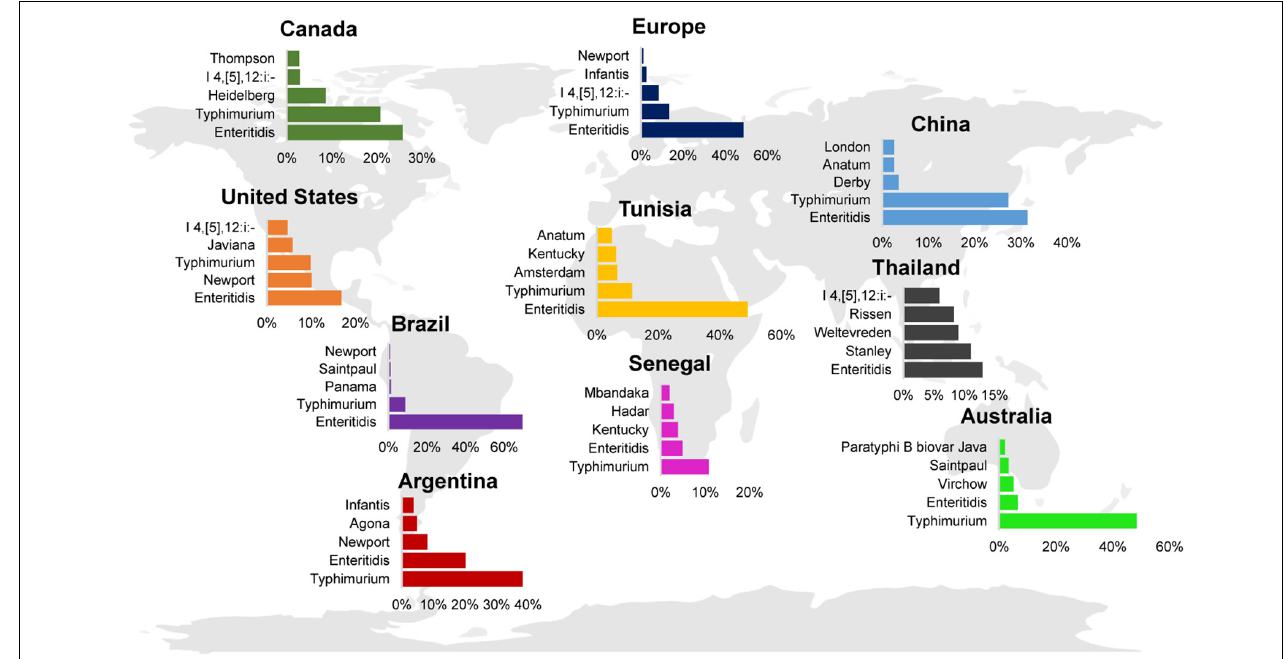
FIGURE 4 | Global distribution of the top 5 NTS serovars associated with human clinical disease. Bar charts represent the top 5 NTS (i.e., serovar Typhi was excluded) serovars reported for Argentina (2007) (Hendriksen et al., 2011), Australia (2011) (OzFoodNet Working Group, 2015), Brazil (2007) (Hendriksen et al., 2011), Canada (2007) (Hendriksen et al., 2011), China (2008) (Ran et al., 2011), the European Union (2016) (European Food Safety Authority [EFSA] and European Centre for Disease Prevention, and Control [ECDC], 2017), Senegal (2007) (Hendriksen et al., 2011), Thailand (2004) (Hendriksen et al., 2009), Tunisia (2007) (Hendriksen et al., 2011), and the United States (2016) (Centers for Disease Control and Prevention [CDC], 2016). Only human clinical cases are reported; data were reported from 2004 to